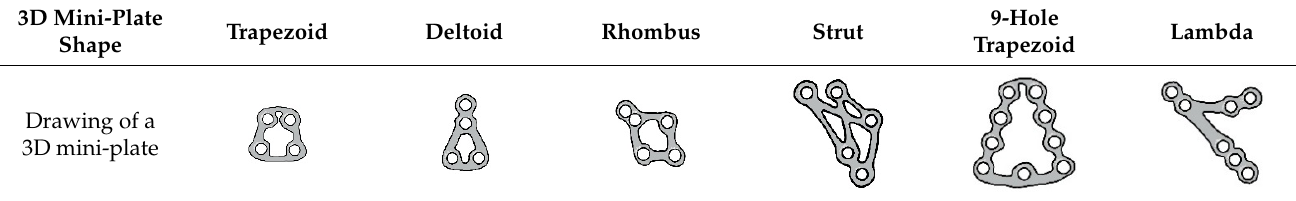
9-Hole Trape- Lambda zoid